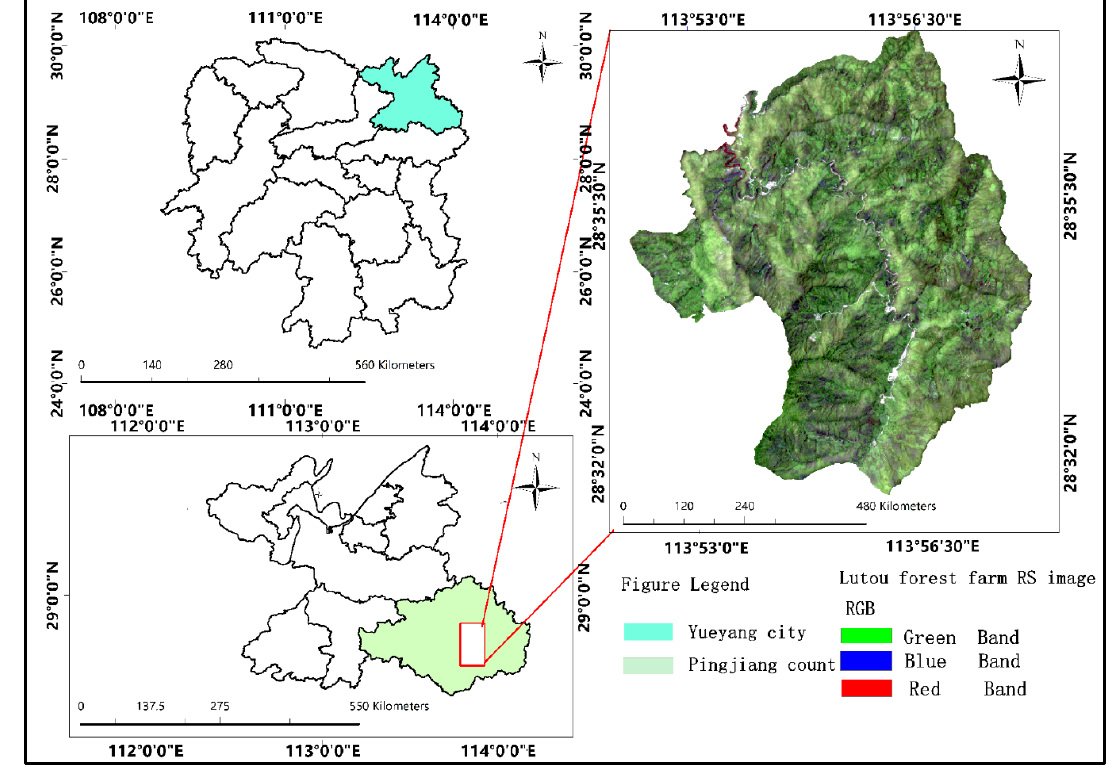
Figure 1. Location of the study